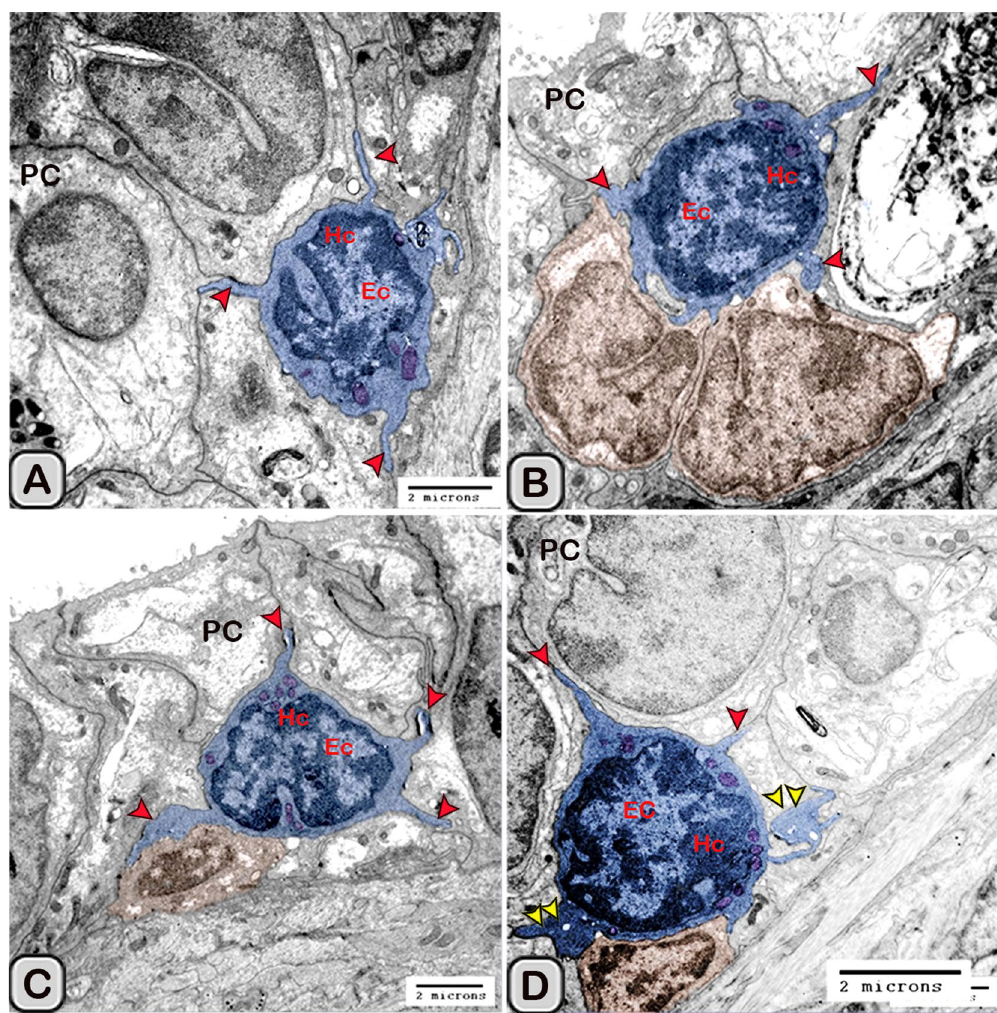
Figure 12. Digitally colored transmission electron microscope images of the DCs in the seminal vesicles of control groups. (A–D) DCs (blue) varied in shape which could be polyhedral, round or triangular. (A–C) The DCs located at the basement membrane or near from the basement membrane and in close association to T-lymphocytes (brown). (A–C) The cytoplasmic cell processes of dendritic cells were long (red arrowheads) and thick bulbous like cell processes ( D , yellow arrow heads). HC heterochromatin, EC euchromatin, PC principal